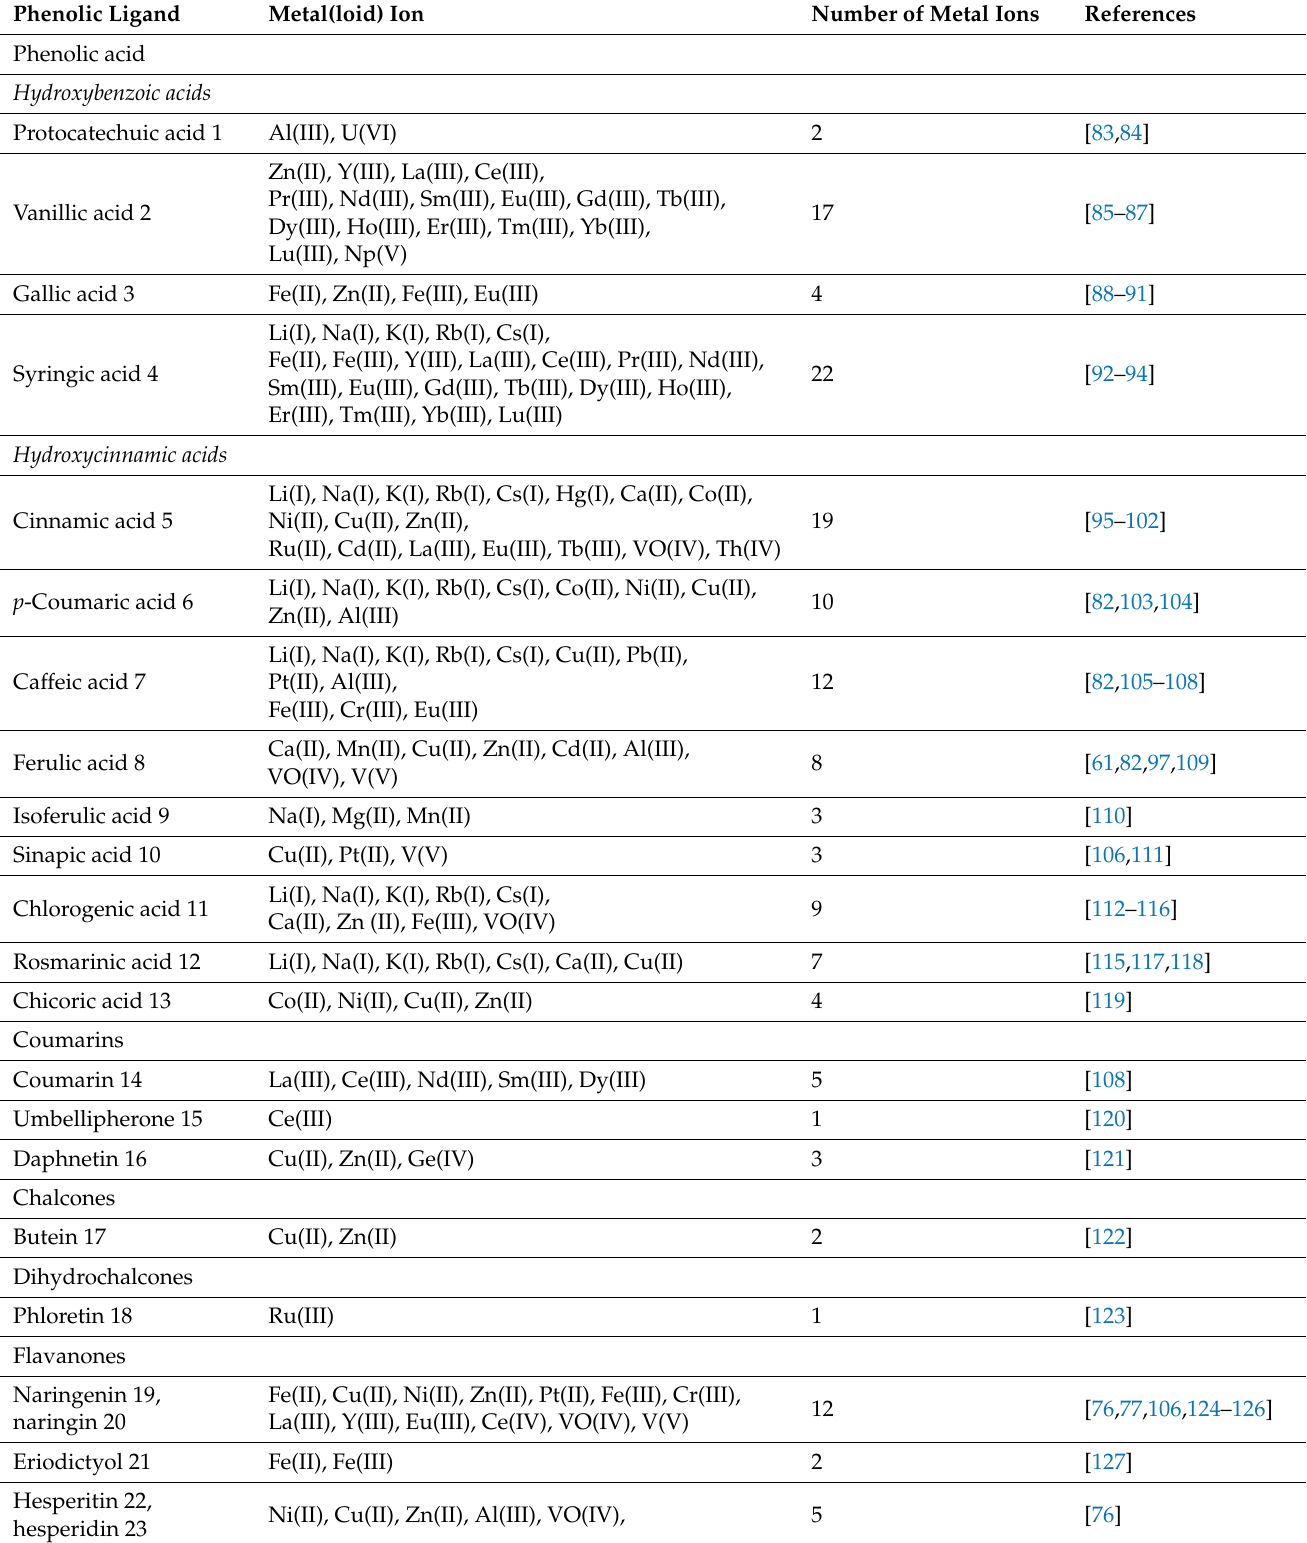
Table 1. Complexes of plant phenolic ligands with metal(loid)